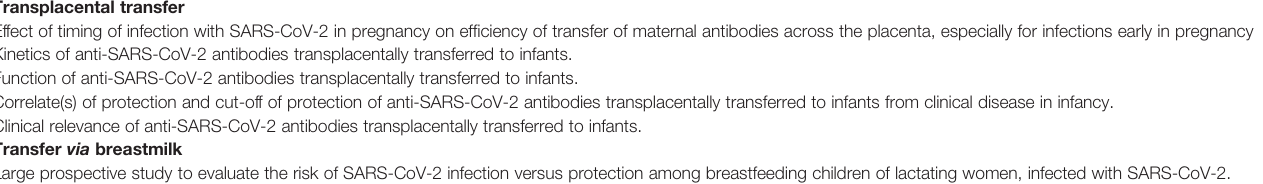
TABLE 2 | Consensus on priorities for future research related to transfer of anti-SARS-CoV-2 antibodies after SARS-CoV-2 infection in pregnancy across the placenta and in breastmilk. Transplacental transfer Effect of timing of infection with SARS-CoV-2 in pregnancy on ef fi ciency of transfer of maternal antibodies across the placenta, especially for infections early in pregnancy Kinetics of anti-SARS-CoV-2 antibodies transplacentally transferred to infants. Function of anti-SARS-CoV-2 antibodies transplacentally transferred to infants. Correlate(s) of protection and cut-off of protection of anti-SARS-CoV-2 antibodies transplacentally transferred to infants from clinical disease in infancy. Clinical relevance of anti-SARS-CoV-2 antibodies transplacentally transferred to infants. Transfer via breastmilk Large prospective study to evaluate the risk of SARS-CoV-2 infection versus protection among breastfeeding children of lactating women, infected with SARS-CoV-2. Humoral immune responses in breastmilk of lactating women, infected with SARS-CoV-2 (titer, subclass, glycosylation pro fi le and functional properties of infection- induced antibodies, including neutralization properties). Impact of COVID-19 infection on cellular immunity in breastmilk: 1. T-cell subsets directed against SARS-CoV-2 expressed in breastmilk after COVID-19